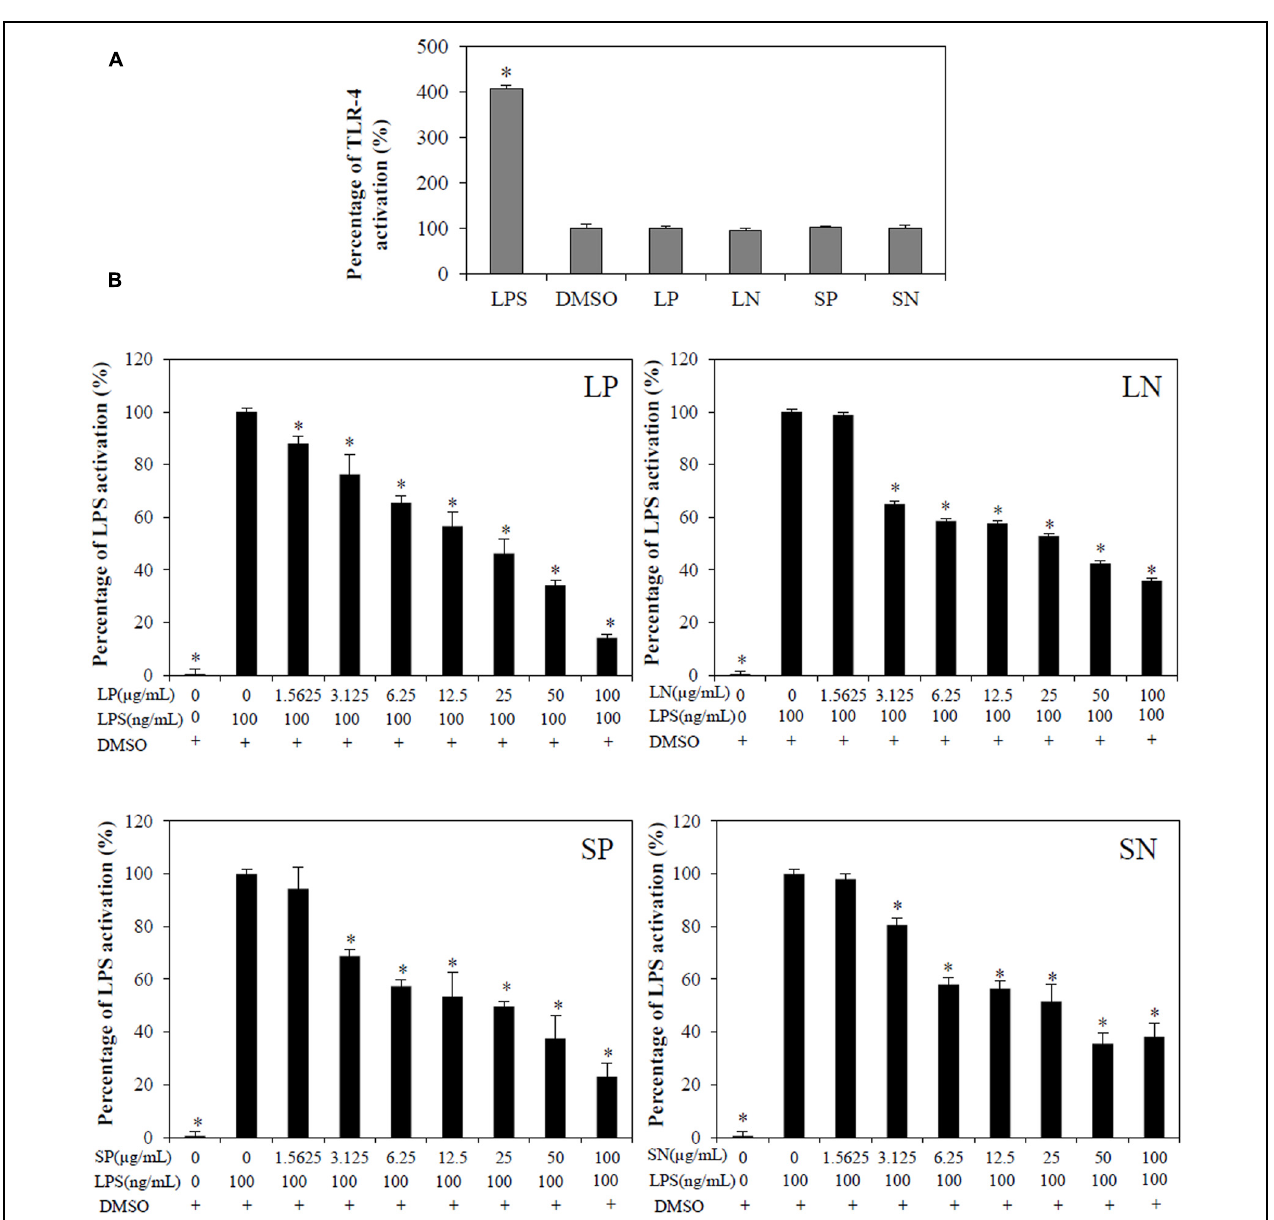
FIGURE 3 | Effect of C. nutans extracts on TLR-4 activation in HEK-Blue TM -4 cells. (A) Cells treated with 100 μ g/mL of LP, LN, SP, SN failed to induce TLR-4 activation, while 100ng/mL of LPS induced significant TLR-4 activation ( ∗ p < 0.05, one-way ANOVA post hoc Dunnett’s t -test) as compared to cells treated with 0.1% DMSO. (B) Cells were treated with various concentrations of extracts (1.5625–100 μ g/mL) or 0.1% DMSO for 1 h followed by 18 h of LPS induction (100 ng/mL). Statistical significant difference from LPS induction are indicated as ∗ p < 0.05 by one-way ANOVA post hoc Dunnet’s t -test. Each value represents means ± SD from three independent